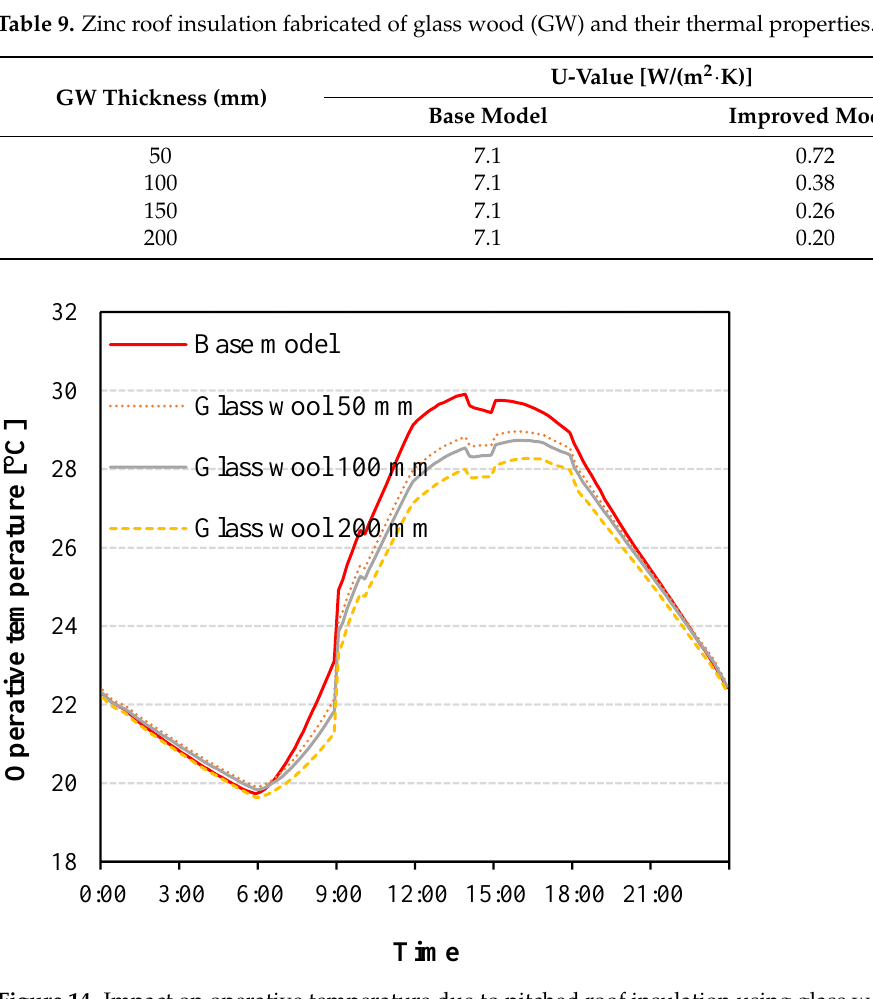
Figure 14. Impact on operative temperature due to pitched roof insulation using glass wool (GW).